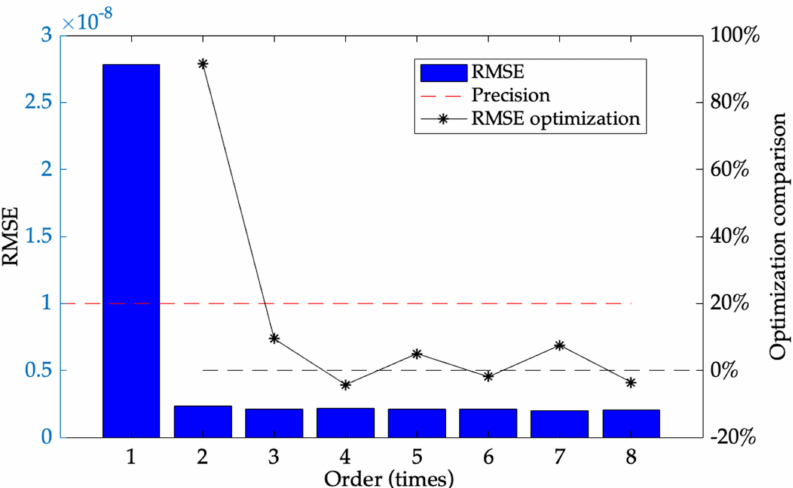
Figure 3. The comparison of RMSE in each